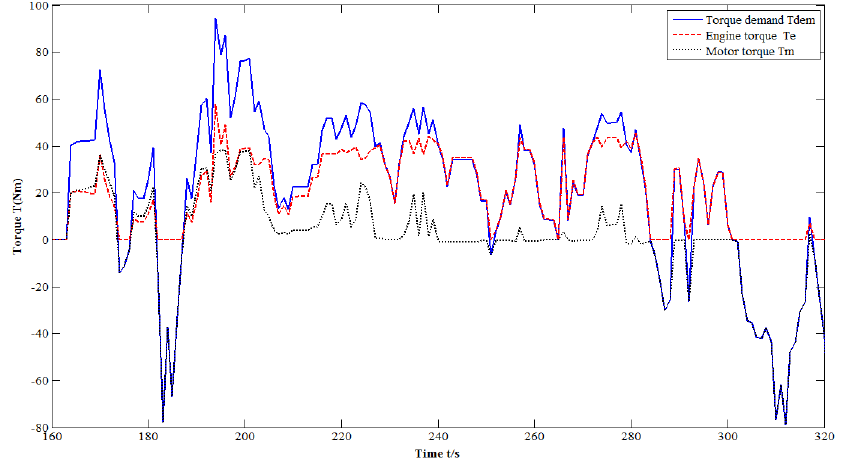
Figure 12. Torque split trajectory by using the FQL control strategy under